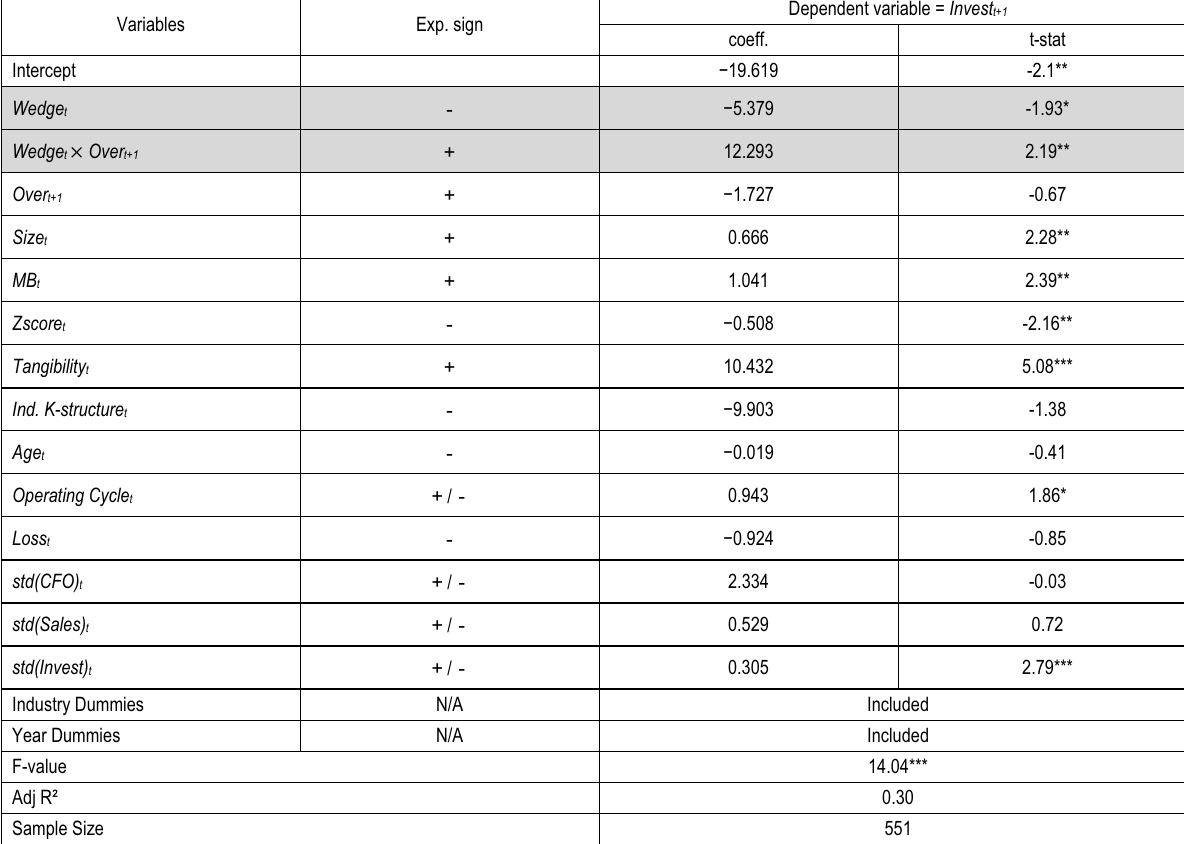
Table 3. The effect of controlling shareholders’ ownership on investment efficiency Variables Exp.